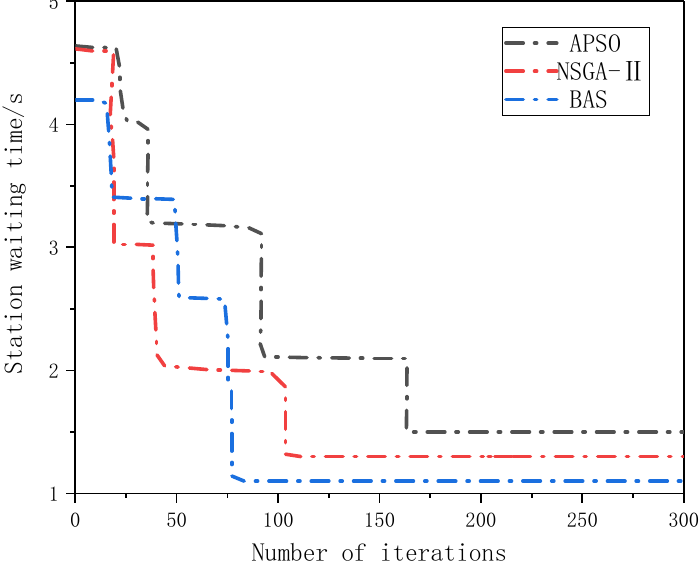
Figure 5. Iteration diagram of station waiting time.